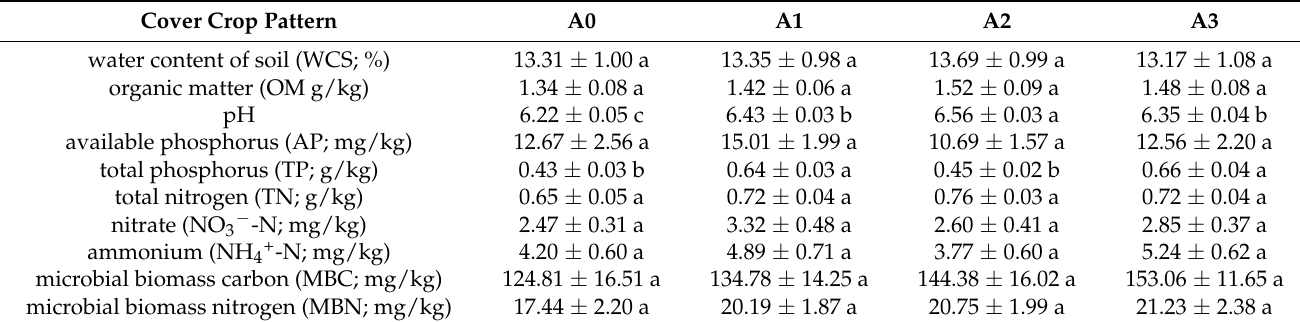
Table 1. Soil physical and chemical properties under different cover crop patterns. Different lowercase letters indicate significant differences between different cover crop patterns ( p < 0.05).